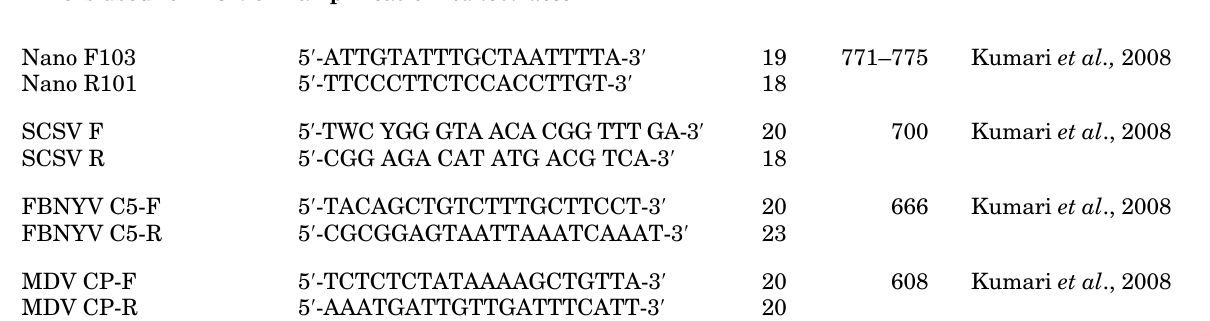
a BWYV, Beet western yellows virus ; SbDV, Soybean dwarf virus ; BLRV, Bean leafroll virus ; CpCSV, Chickpea chlorotic stunt virus ; SCSV, Subterranean clover stunt virus ; FBNYV, Faba bean necrotic yellows virus; MDV, Milk vetch dwarf virus ; rep, replicate gene; CP, coat protein gene. b R=AG, W=AT,